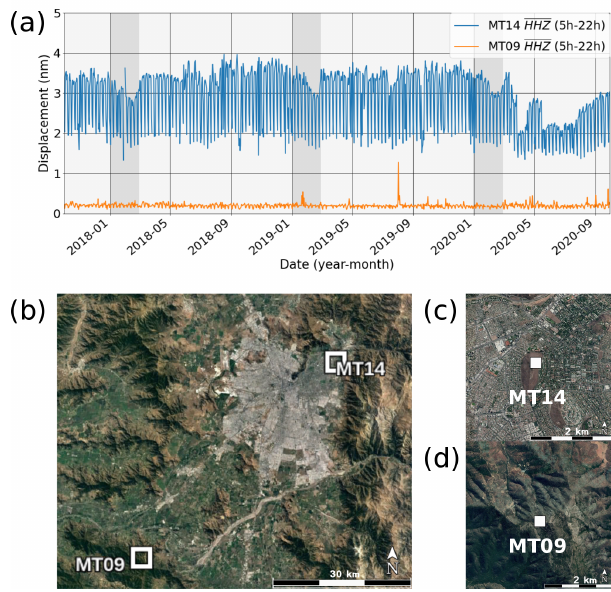
Figure 5. Displacement noise evolution at urban and rural stations in the metropolitan region for the period 1 October 2017–1 October 2020. (a) Long-term noise evolution in station MT14 (blue line) and MT09 (orange line). The grey background correspond to summer vacations. (b) Map with the relative position of each station in the metropolitan region and the near 2km distance from stations (c) MT14 and (d) MT09. Photos from © Google